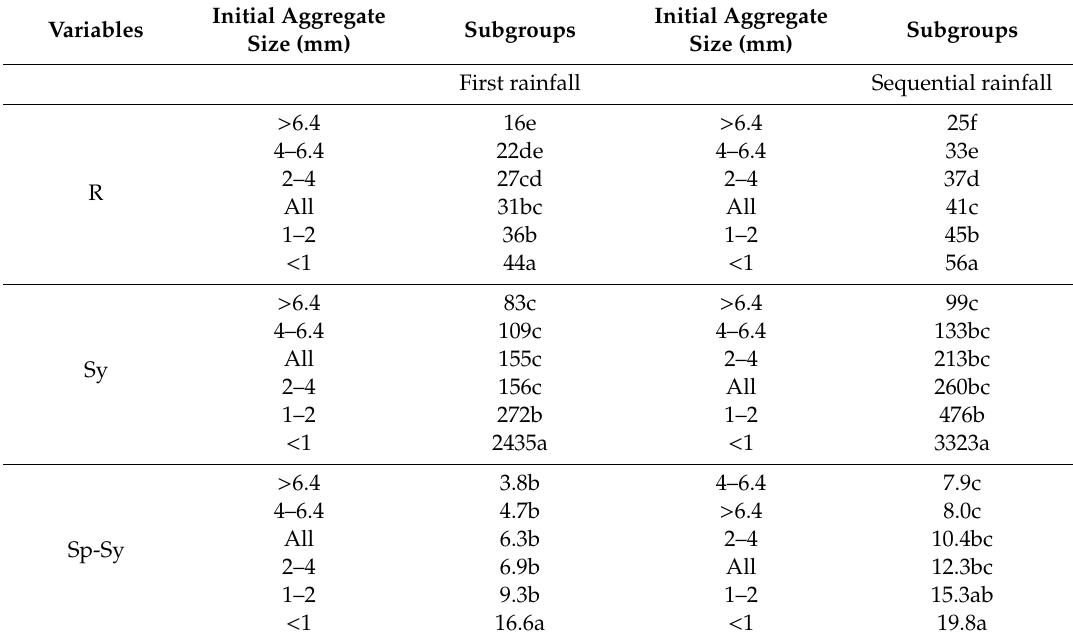
Table 6. Duncan test results through the initial aggregate sizes ( α = 0.05).